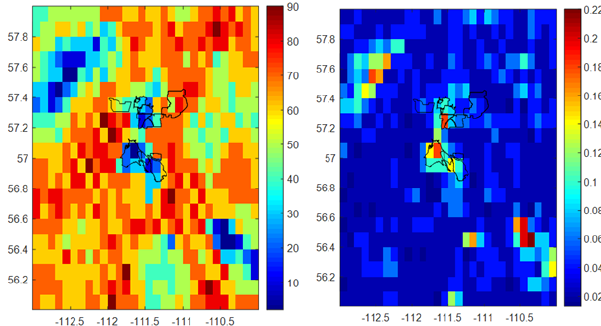
Figure 3. Map of sample size (left) and average cloud fraction within AOD superpixels when the AOD retrieval is successful (right), compiled from the entire AATSR data record. Smaller sam- ple sizes are expected over Moose Lake and Gordon Lake (56.5 ◦ N, 110.5 ◦